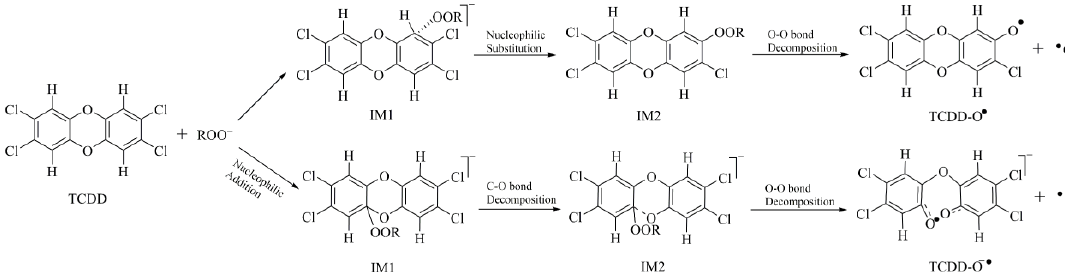
Figure 7. Proposed reaction mechanism for the reaction of ROO − (R=H or alkyl groups) with TCDD.